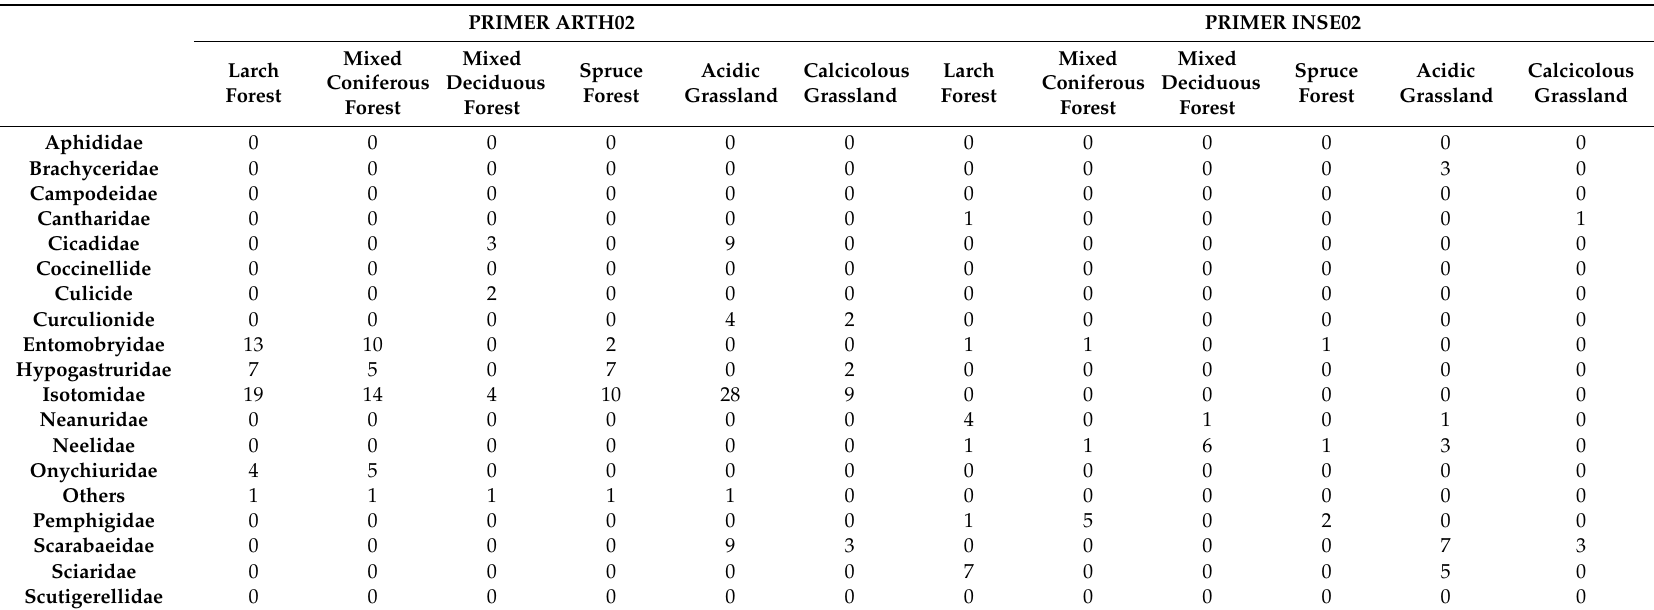
Table 2. Sequences of arthropods detected with eDNA metabarcoding with the primer ART02 and